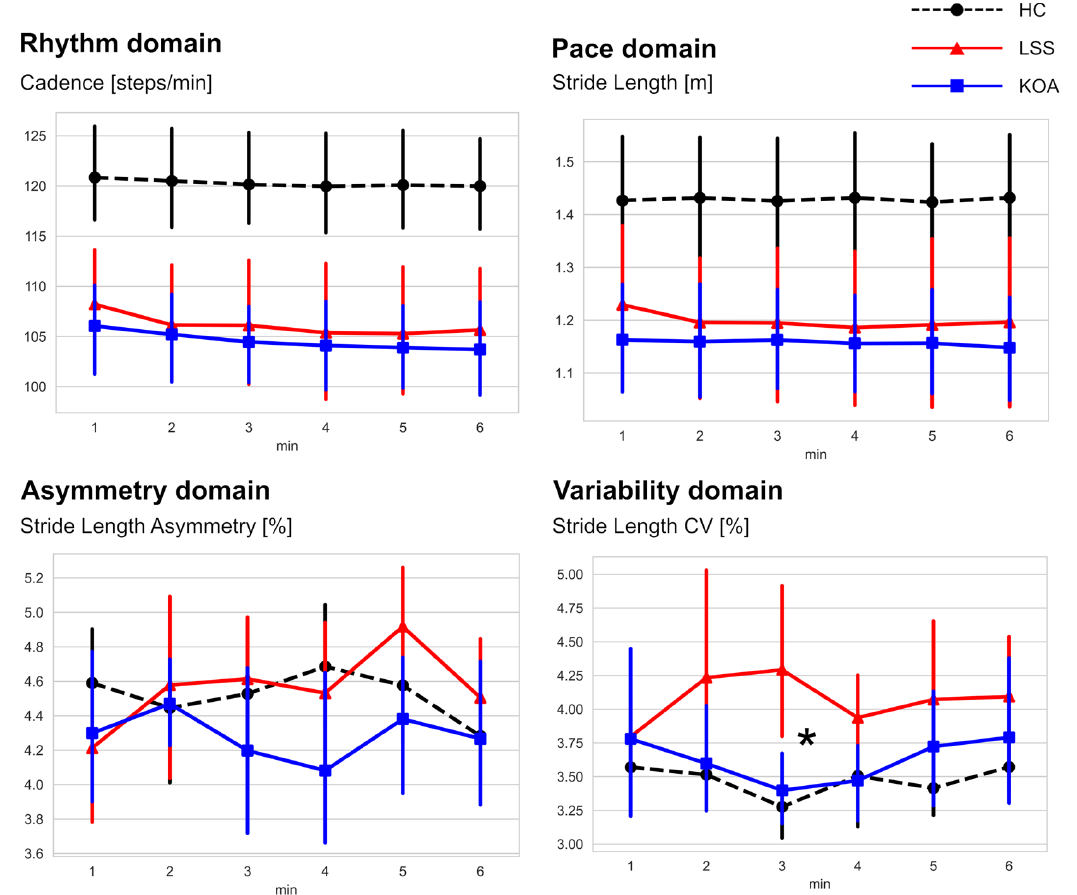
Figure 2. Changes in representative parameters from the minute-by-minute analysis of the 6MWT. The * identifies a significant difference between LSS and KOA ( p < 0.05). (HC; healthy control, LSS; lumbar spinal stenosis, KOA; knee osteoarthritis, CV; coefficient of